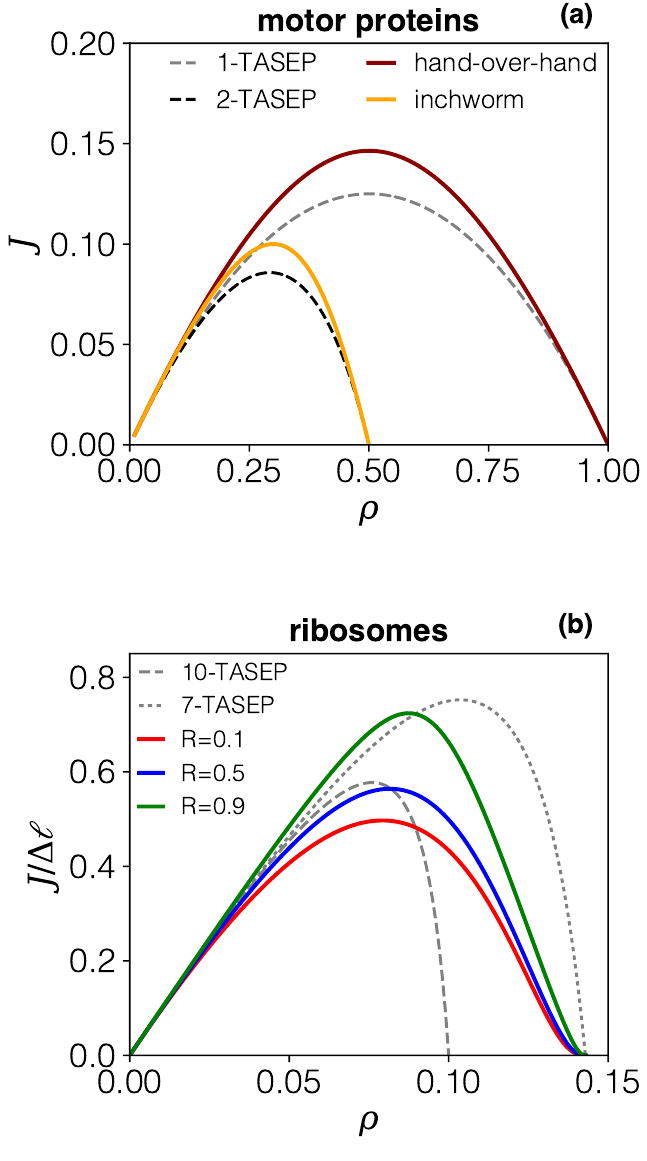
Figure 8: Current J as a function of particle density ρ . Standard TASEP with ex- tended particles of size (cid:96) = 1 and (cid:96) = 2 are plotted with dashed lines (gray and black line respectively) in panel (a). In panel (a) we also plot the two mechanisms (hand-over-hand: (cid:96) − = 1, (cid:96) + = 2, and inchworm: (cid:96) − = 2, (cid:96) + = 3) for R = 0.5. In panel (b) we show the current for the inchworm-like movement of the ribosomes (cid:96) = 7, (cid:96) = 10, for different values of R and setting the time scale by fixing the ef- − + = 10 / s, which is the usually accepted rate for ribosome fective rate to γ eff